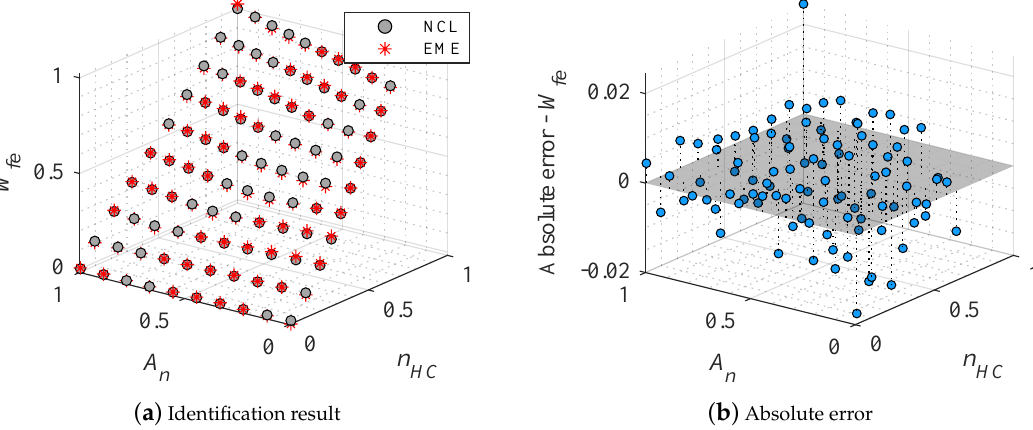
Figure 7. The identification result and absolute error of the EM ( α = [ n HC , A n ]) W fe